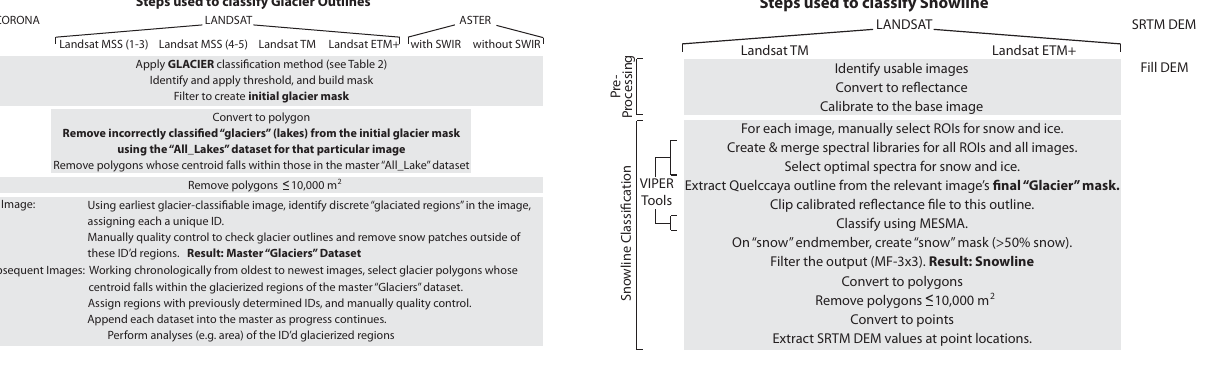
Fig. 7. Steps summarizing the processes used to classify glacier snow lines (specifically the QIC in this study). As with Figs. 4 and 6, grey background overlaps those data sets to which each process applies, and bold text indicates important steps or data